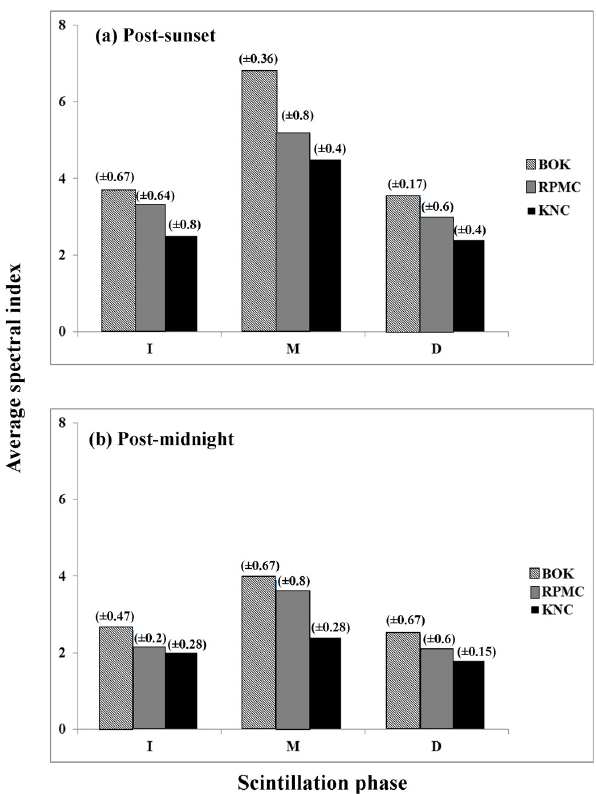
Fig. 8. Variation of average spectral index during the initiation stage (0–15min), middle phase (15–30min) and decay phase (last 15min) of scintillation patch. The numbers in the brackets indi- cate standard deviation of the mean. Panel (a) pertains to post- sunset while (b) for post-midnight scintillation respectively. “I”, “M” and “D” indicate initial, middle and decay phase respectively. For S 4 > 0 . 2 the initial phase is assumed to start.